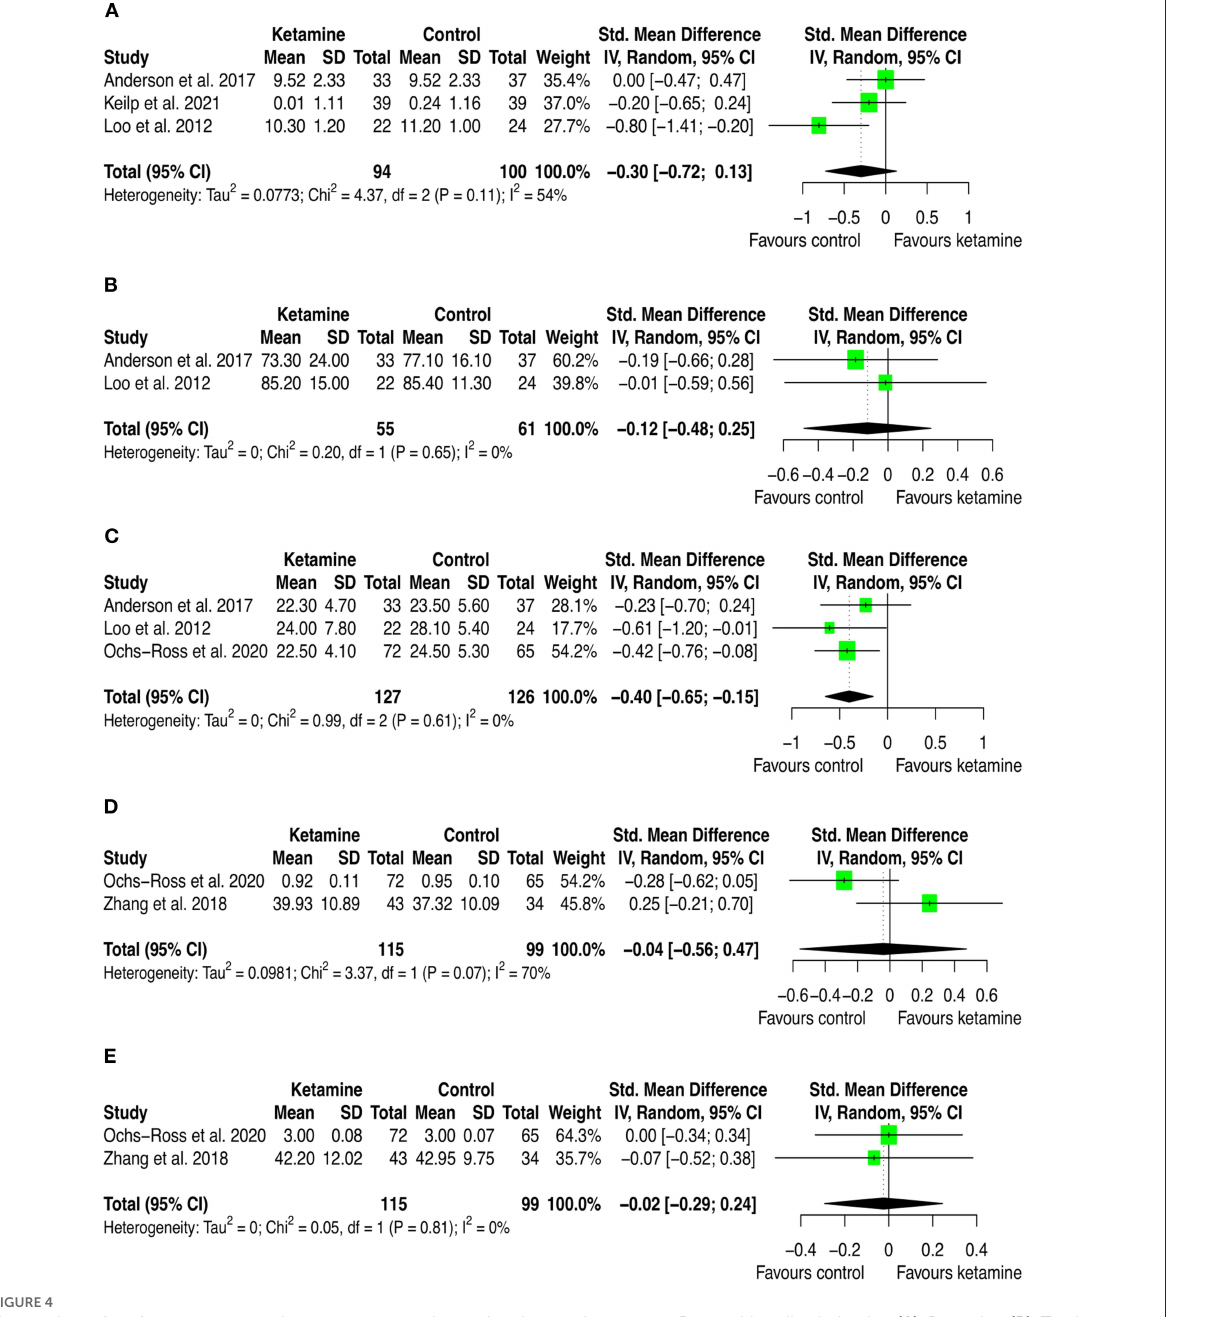
control (i.e., the go/no-go task) was observed only among the responders from the 0.5 mg/kg ketamine infusion